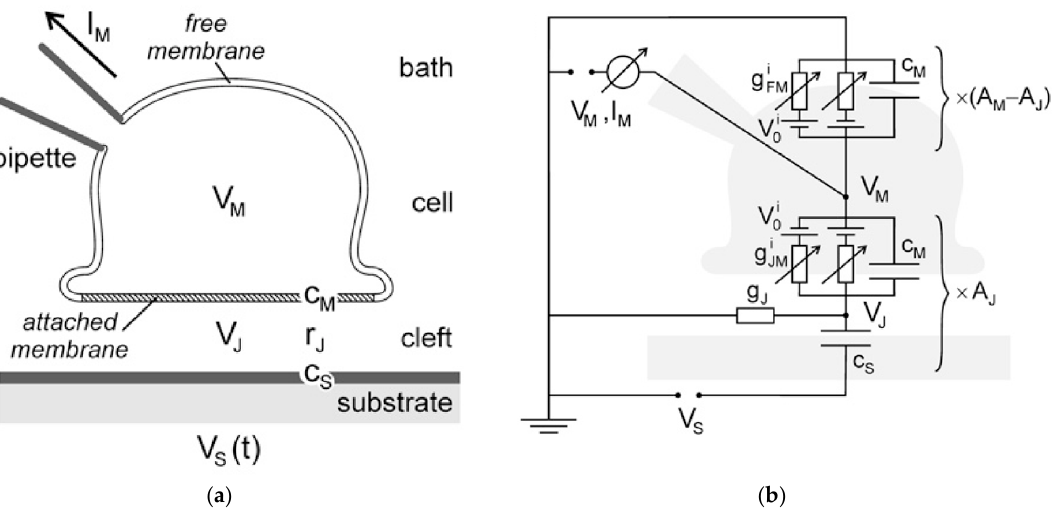
Figure 16. ( a ) Schematic view of a neuron interfaced with a capacitor; ( b ) Equivalent circuit of the neural interface in ( a ), where A M is the area of the cell membrane, A J is the area of the cell/sensor junction and A M –A J is the area of the free membrane. Reprinted from [148]. Copyright 2007, with permission from Elsevier.